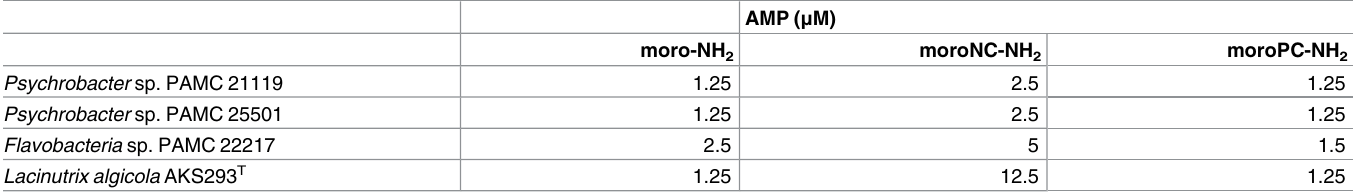
Table 6. AMP activity against Psychrobacter sp. PAMC 25501 , Flavobacteria sp. PAMC 22217, and Lacinutrix algicola AKS293 T